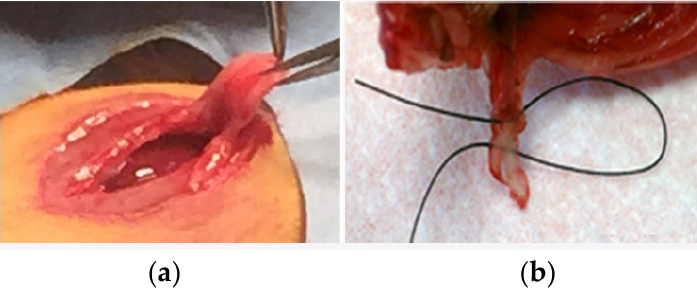
Figure 1. ( a ) Surgical tear of the xyphoid cartilage tissue on the model of cartilage repair; ( b ) suturing the xyphoid tissue with the BMP-coated suture.